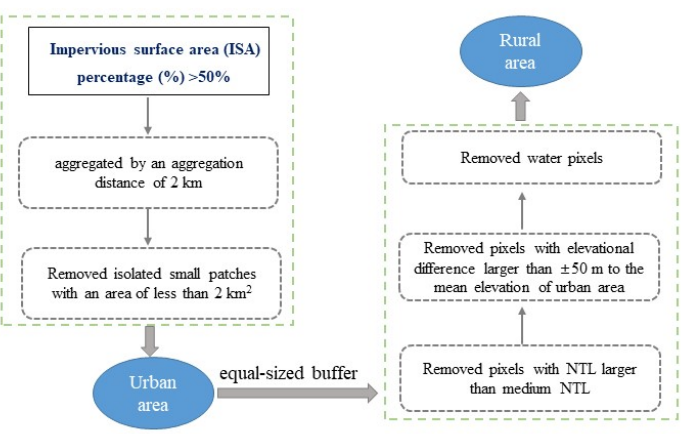
Figure 2. A flowchart for dividing rural areas.